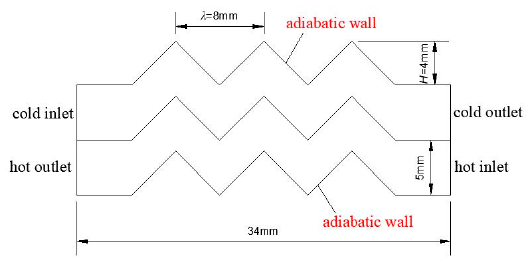
Figure 1. Physical model.